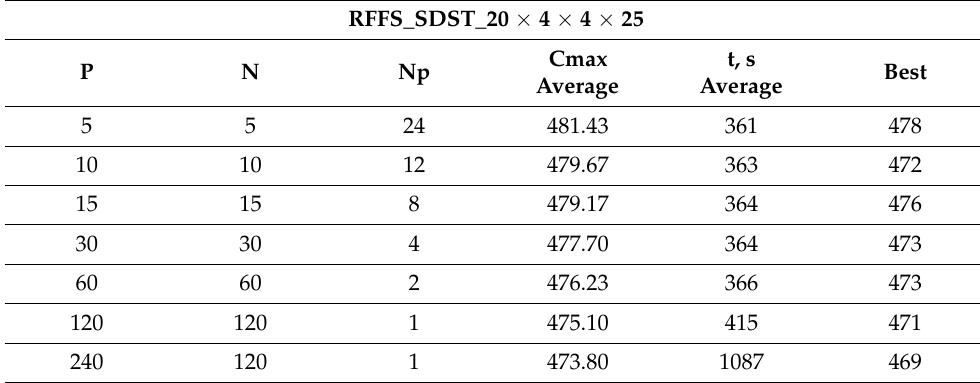
Table 7. RFFS_SDST_20 × 4 × 4 × 25